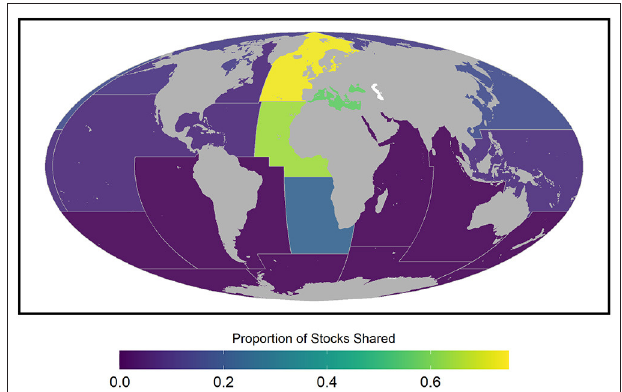
FIGURE 3 | Proportion of transboundary species within major Food and Agriculture Organization fishing regions. Proportions are calculated among 780 fish stocks with known spatial distributions, including stocks that have spatial distribution information but not enough data for the full panel regressions. A threshold of 10 percent is used to designate transboundary